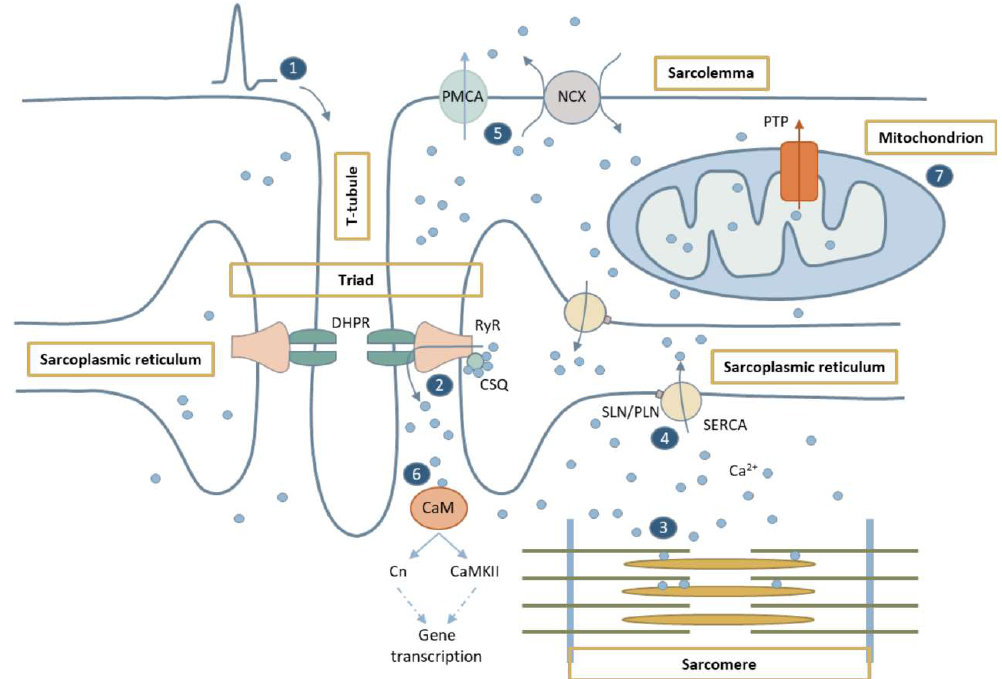
Figure 1. Representation of Ca 2+ fluxes in the muscle fiber. Upon sarcolemmal depolarization reaching T-tubules (1), DHPRs undergo a conformational change that activates RyR1 channels and results in Ca 2+ release from the SR (2). Ca 2+ diffuses to the sarcomere where it initiates muscle contraction (3).